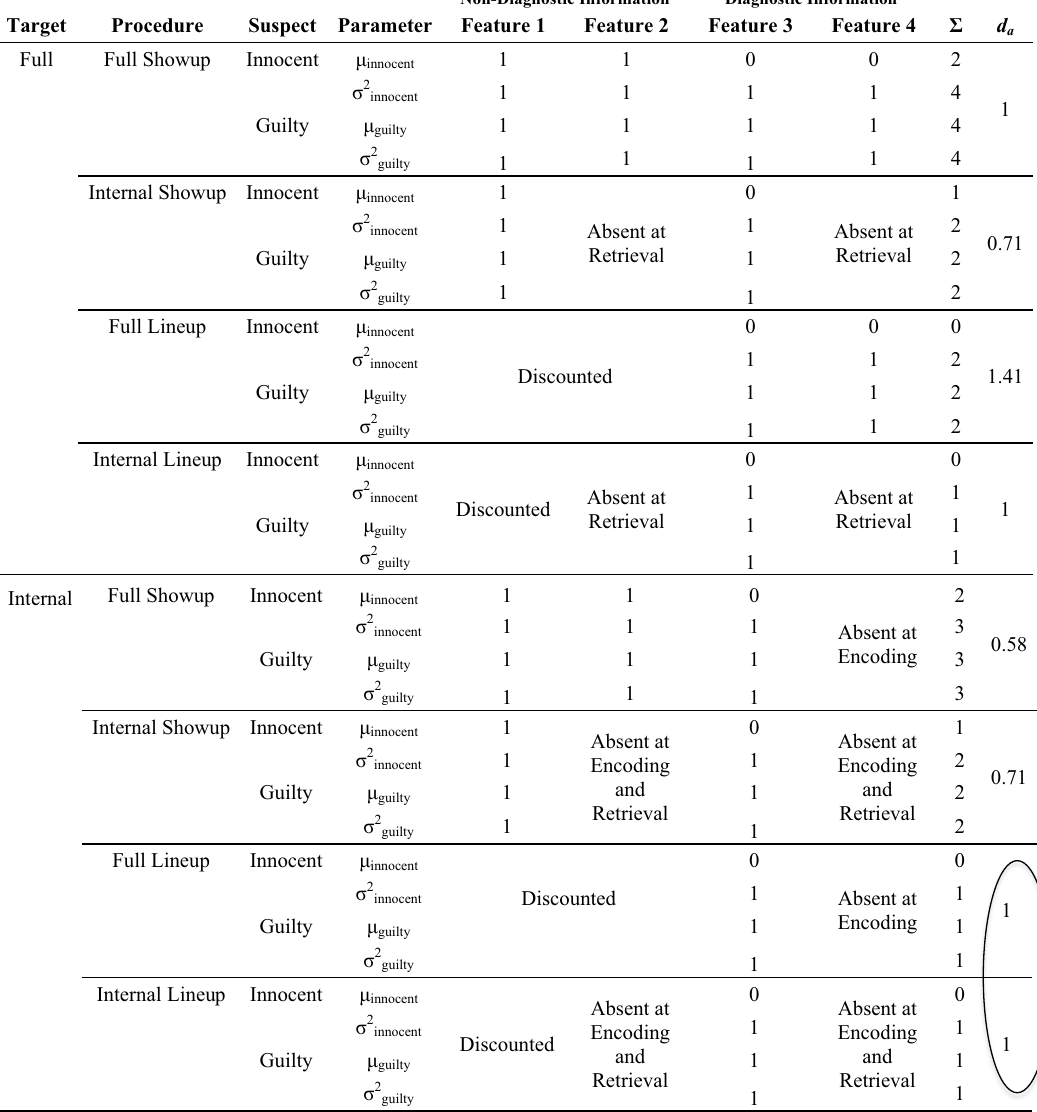
Table 2 Diagnostic feature-detection theory predictions when manipulating the presence of diagnostic and non- diagnostic facial information at encoding and retrieval Non-Diagnostic Information Diagnostic